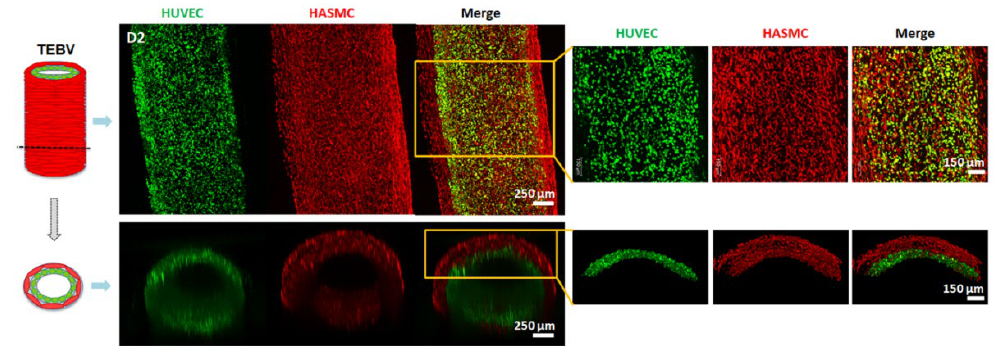
Figure 3. TEBV cell tracker reconstruction with confocal microscope at day 2. Each color indicates different cell types: HUVEC in green and HASMCs in red at day 2. On the right there is a magnification of the TEBV.